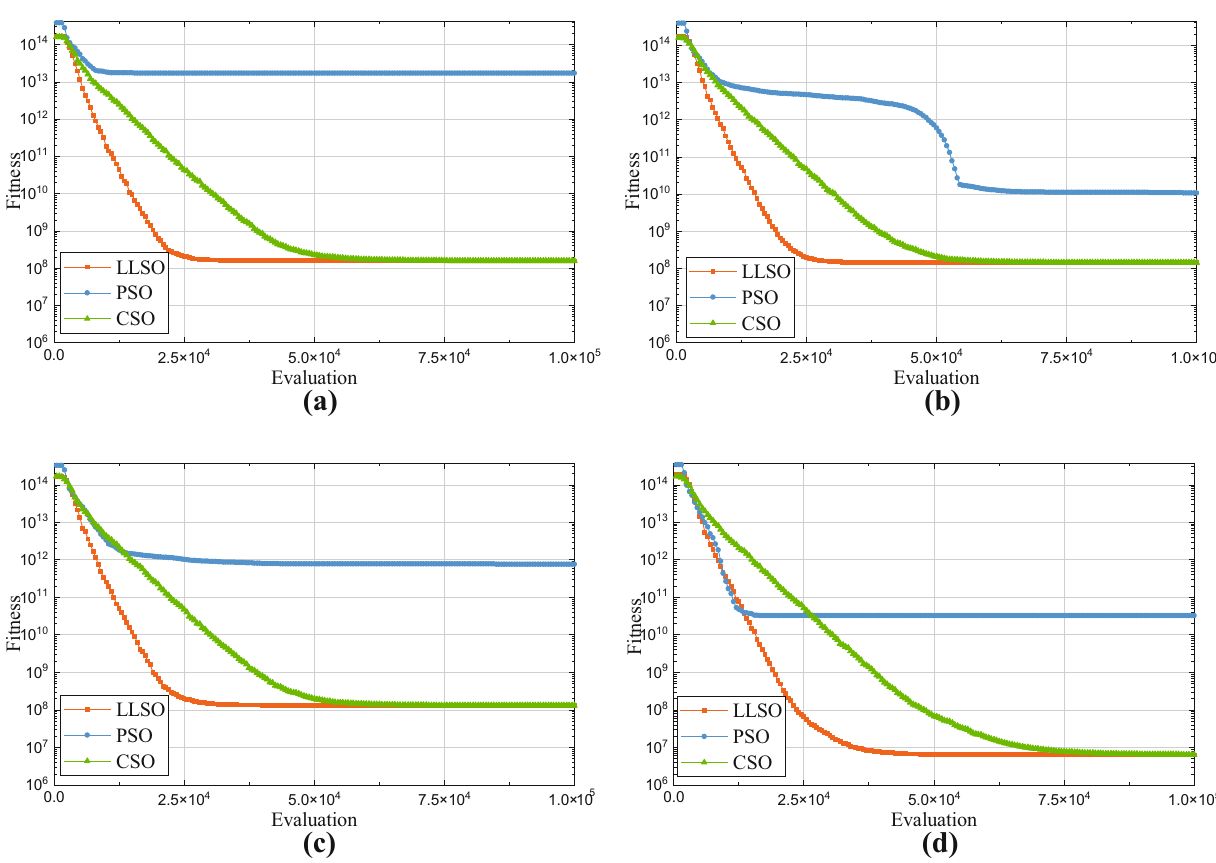
Fig. 4 Comparison results with PSO and CSO in different instances. a 1–4 weeks b 2–5 weeks c 3–6 weeks d 4–7